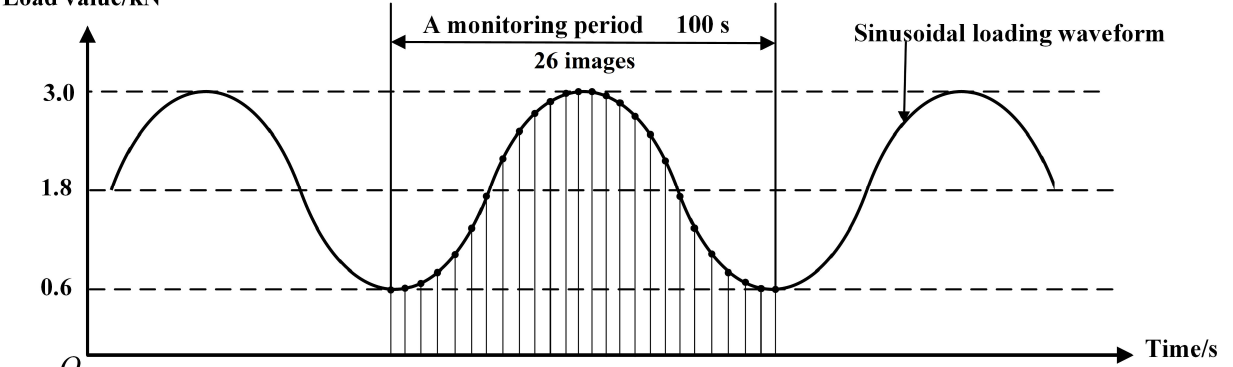
Figure 6. Schematic diagram of acquisition point layout of speckle images in a load cycle. Among the six groups of images collected, the speckle images and the global crack images at the maximum load points are shown in the Figure 7.